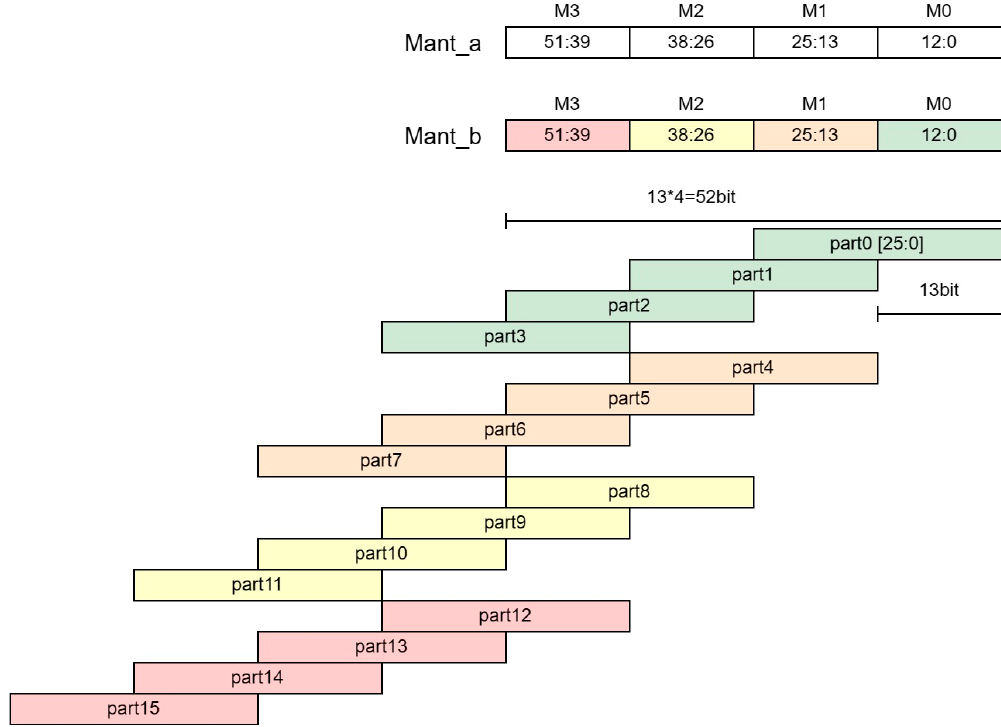
Figure 5. The paradigm of the mantissa multiplication in DCIM-FF.